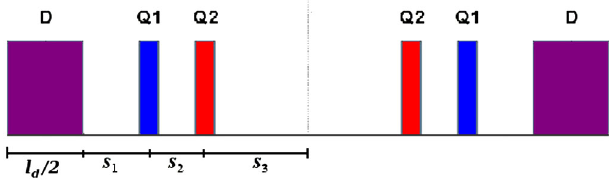
FIG. 1. Schematic layout of the TME